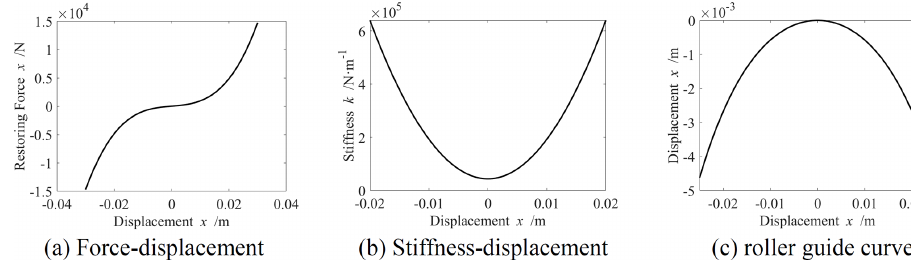
Figure 9. Force, stiffness, roller guide curve of the HSLDS mount.